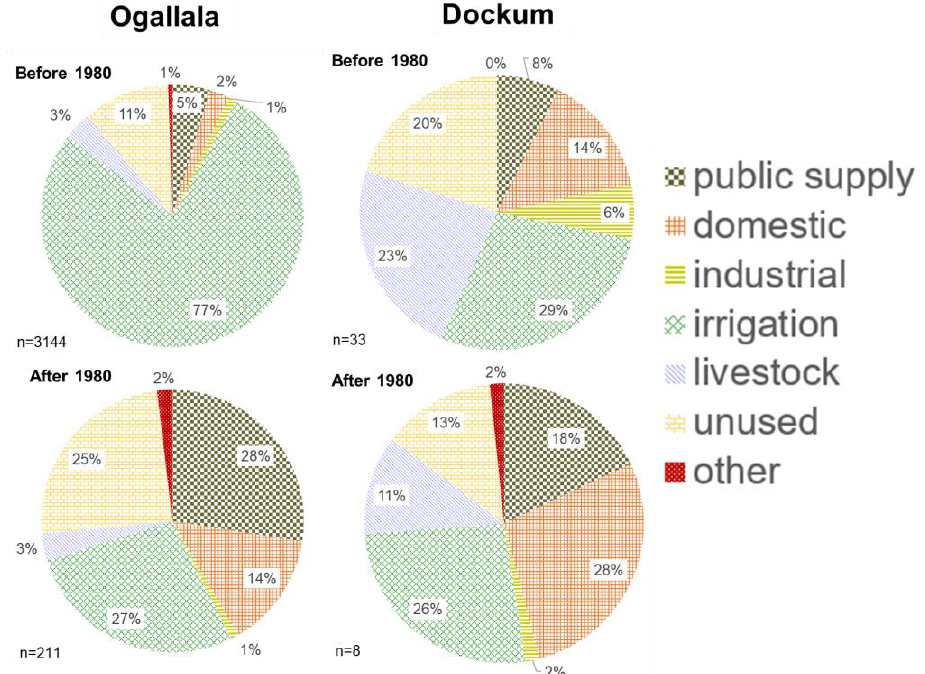
Figure 5. Reported well primary uses for Ogallala and Dockum Aquifers before and after 1980. Wells before 1980 go back to the earliest dates in the record (1900) and wells after 1980 go to the latest record date (2018). All wells which had no definite drilling dates were excluded.